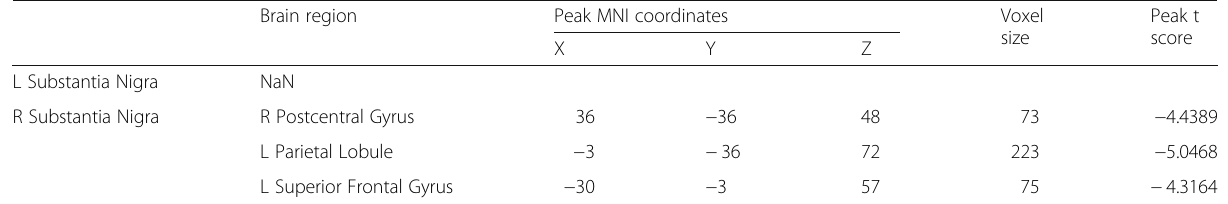
Table 3 Abnormal functional connectivity of the bilateral substantia nigra in patients with MwoA compared with healthy controls Brain region Peak MNI coordinates Voxel